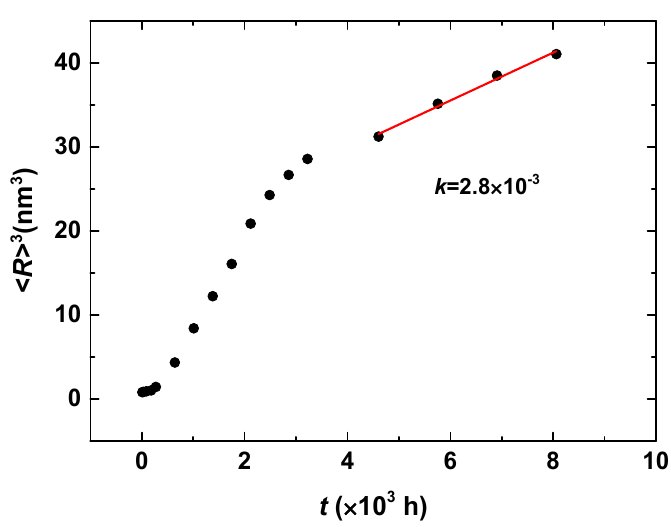
Figure 4. The temporal evolution of the cube of the average particle radius of the Cr-enriched α′ phase at steady-state coarsening in the Fe-25 at % Cr.